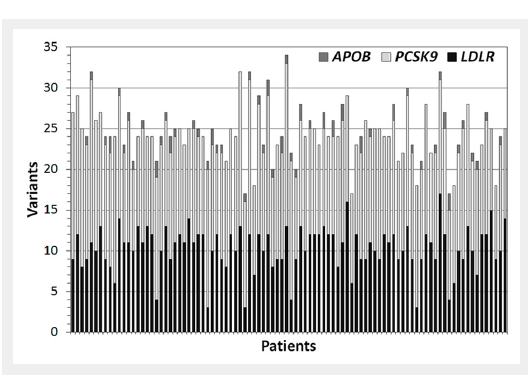
Mean amplicon coverage . Each bar corresponds to one of the 84 samples tested in the second sequencing run. Samples are ranked from the lowest to the highest fold-coverage value. Fold-coverage values of the first 10 samples ranged from 44978 to 53336 (data not shown).